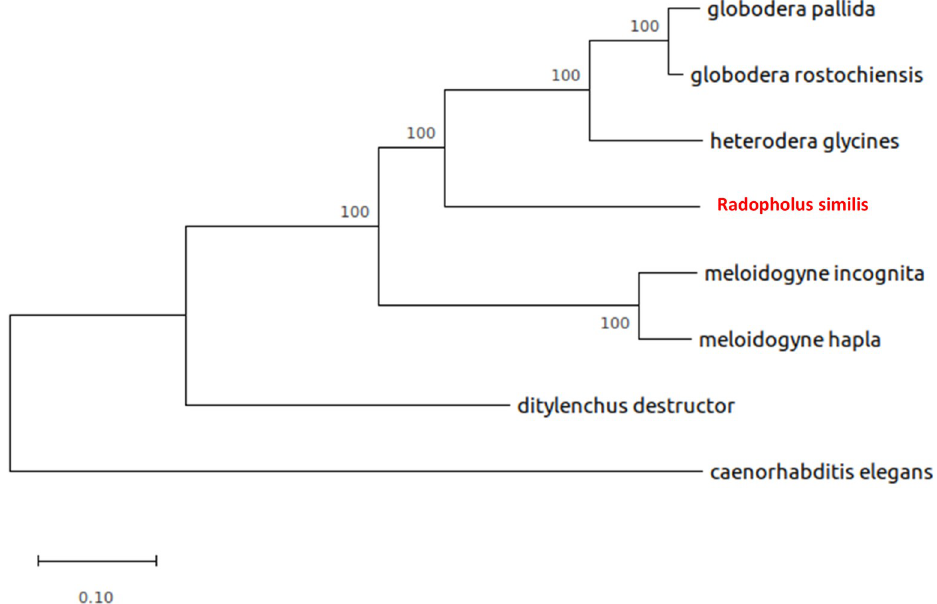
Fig 3. Characterization of species phylogenetic tree. Species tree constructed using concatenated alignments of 1630 orthogroups with minimum of 75% of species having single-copy genes in any orthogroup using the LG + G substitution model determined by MEGA X. Numbers on the branch length indicates bootstrap support value. Bootstrap values were calculated from 1000 replicates. Branch length indicates the number of substitutions per site.